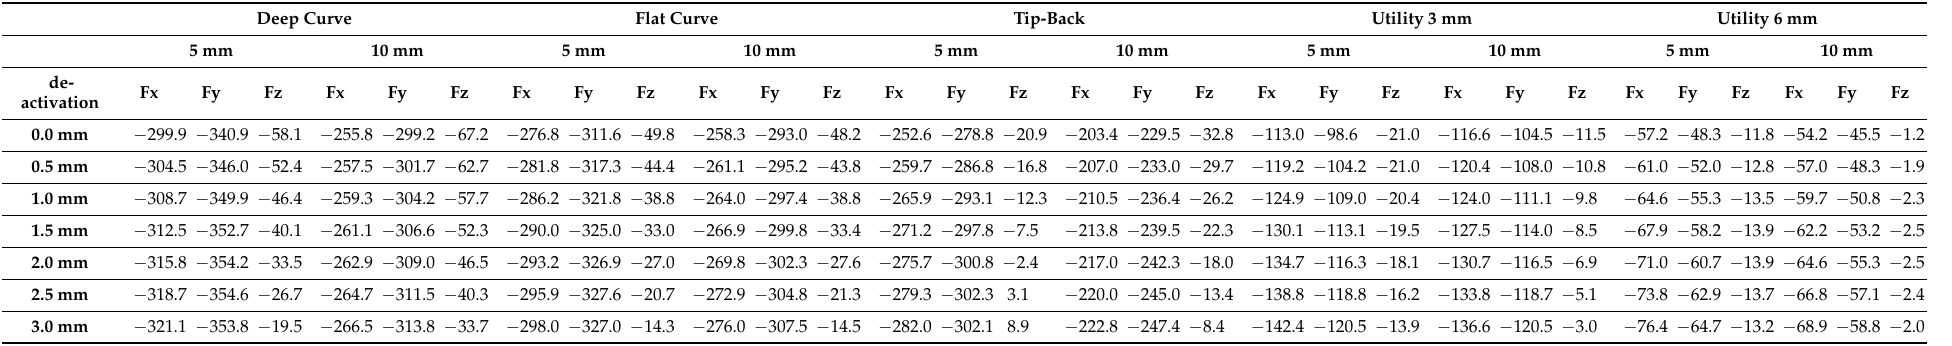
Table 4. Forces (cN) produced by the straight cantilever configurations during